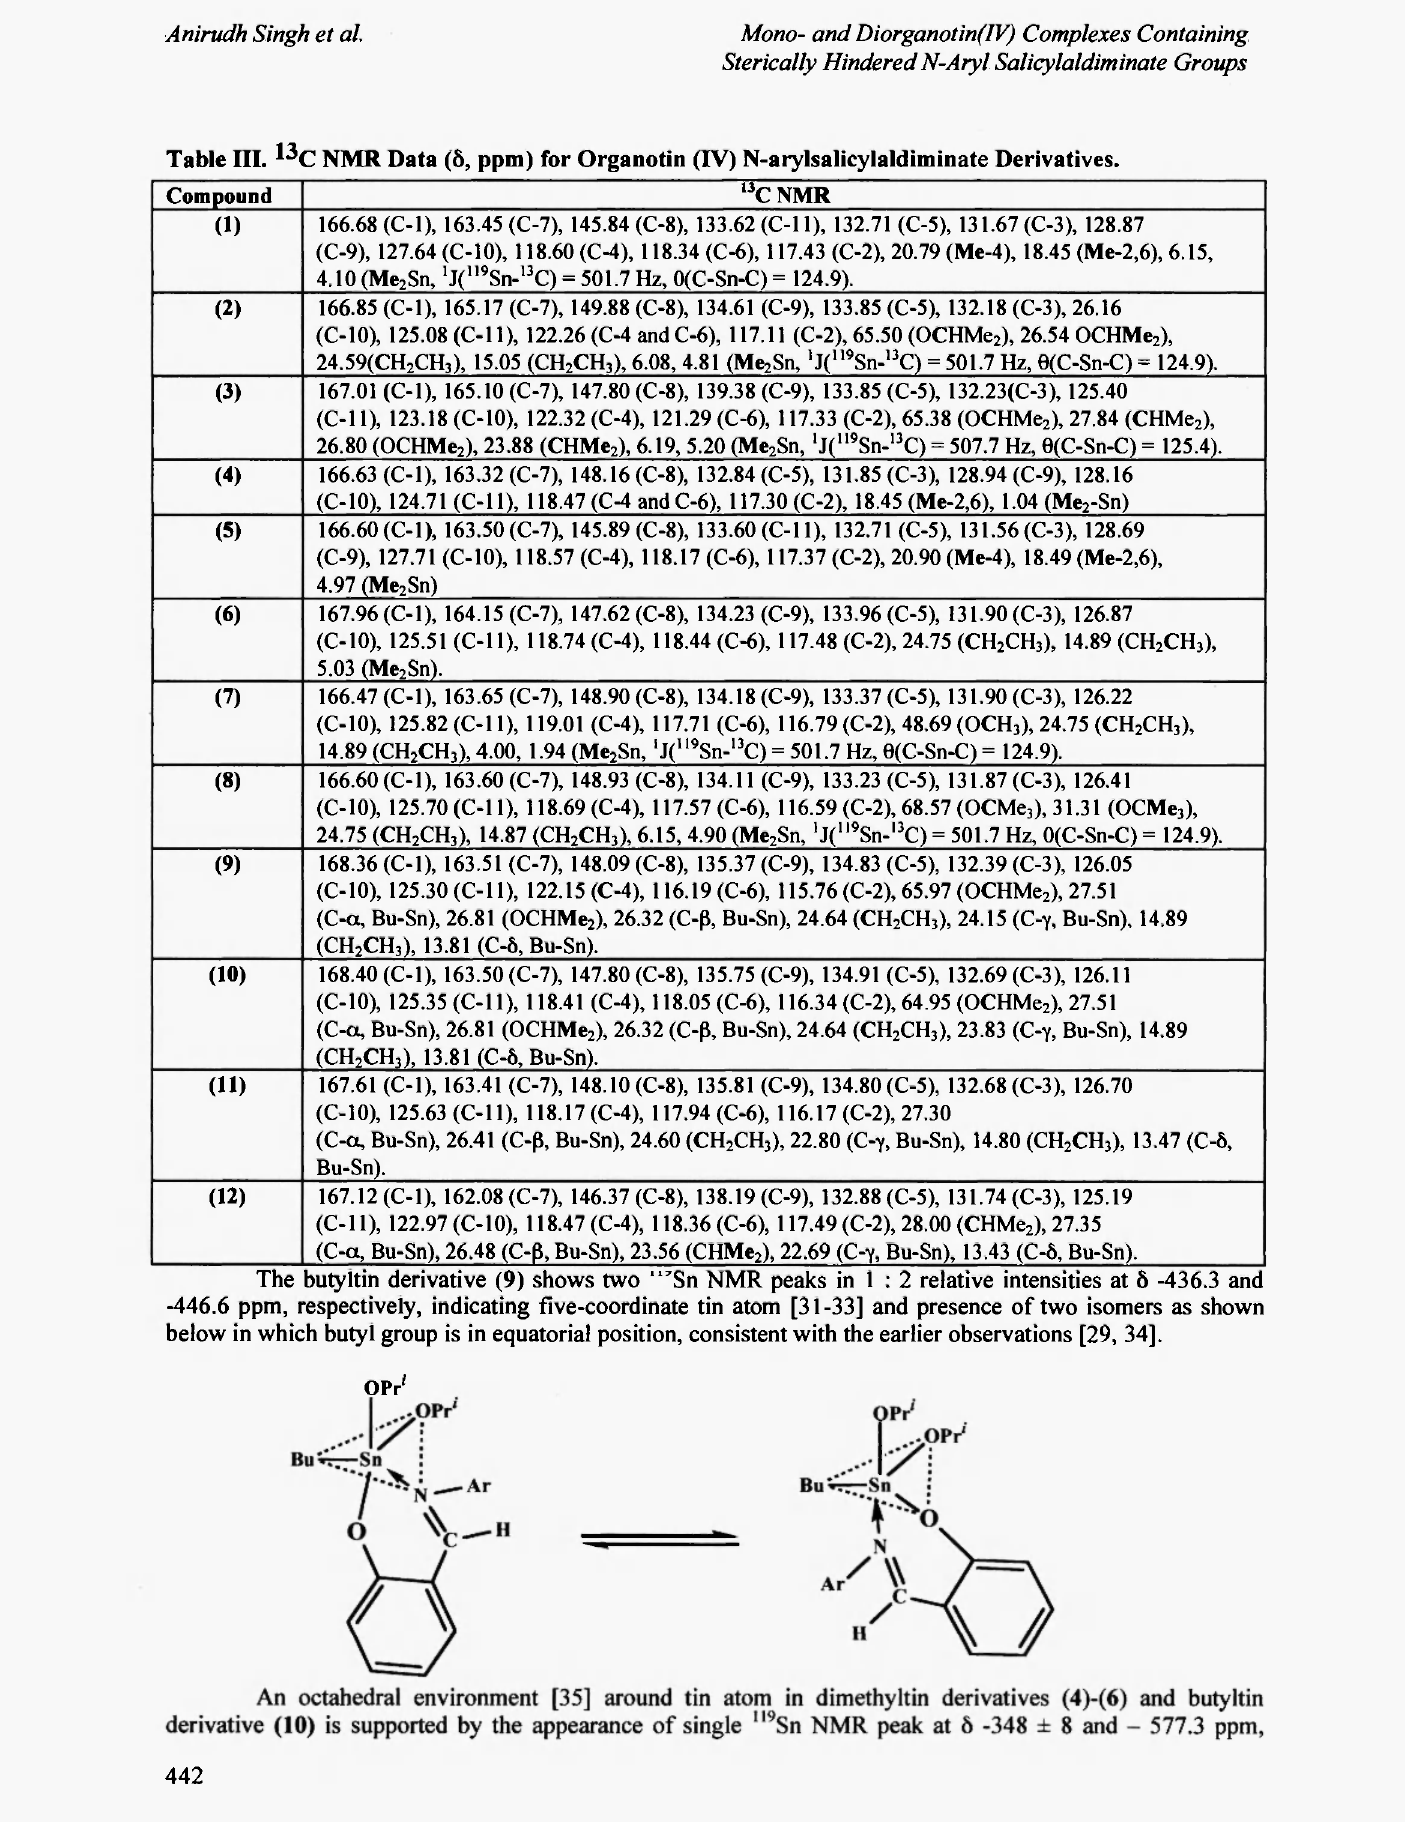
The butyltin derivative (9) shows two Sn NMR peaks in 1 : 2 relative intensities at δ -436.3 and -446.6 ppm, respectively, indicating five-coordinate tin atom [31-33] and presence of two isomers as shown below in which butyl group is in equatorial position, consistent with the earlier observations [29,